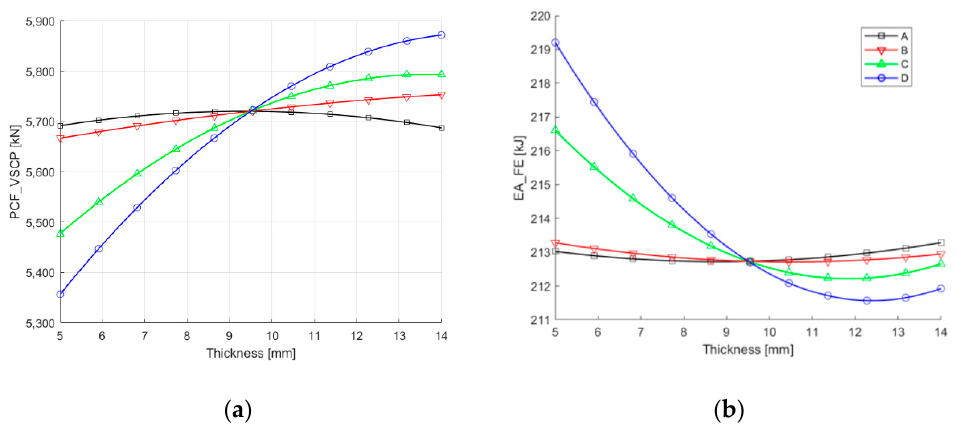
Figure 17. Effect of thickness: ( a ) effect of thickness on PCF_VSCP response; ( b ) effect of thickness on EA_FE response.